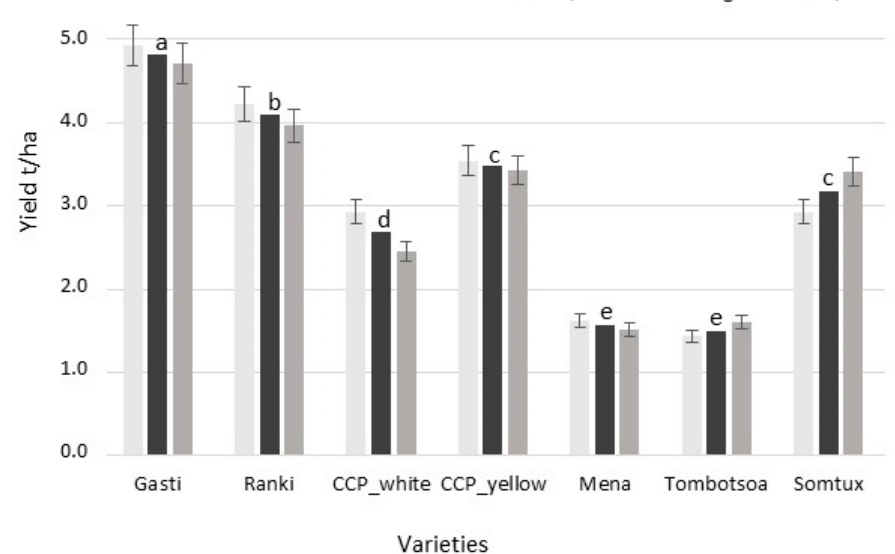
Figure 3. Principal component graph of the half-sib progeny vegetative and productive traits in the two localities. And. = Andiolava; Sat. = Satrokala; NR = number of rank / ear; DIA = ear diameter; NS = number of seed / ear; SW = seed weight / ear; EL = ear length.